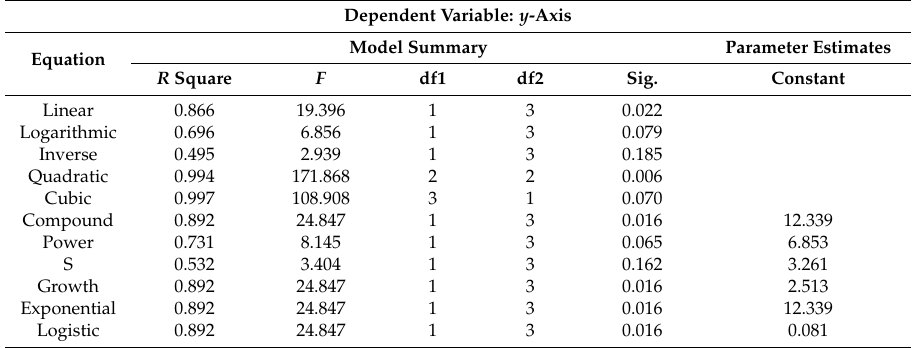
Table A4. Model summary and parameter